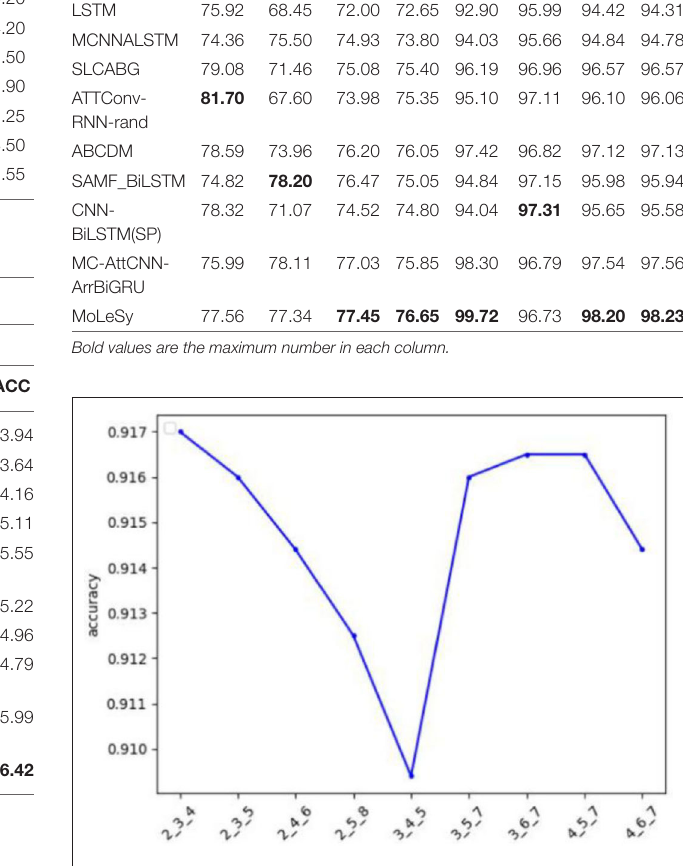
Time Consumption We also compared the time consumption of different models, took the LSTM model as the baseline, and the result is shown in Figure 7